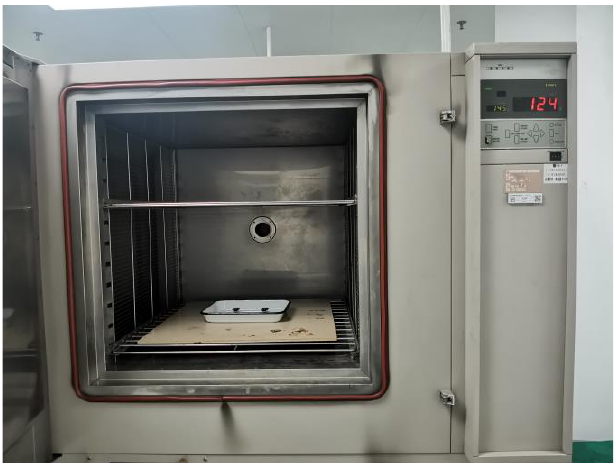
Figure 9. High-temperature accelerated test chamber.